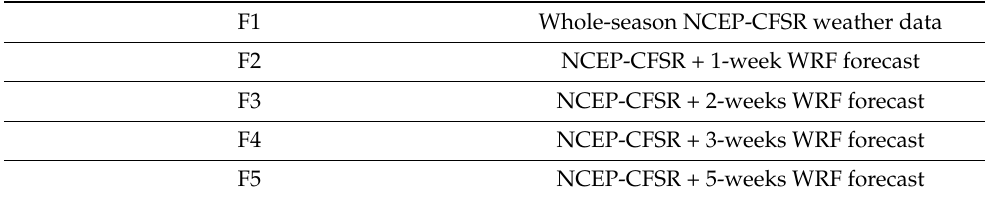
Table 4. Winter-wheat crop forecasting